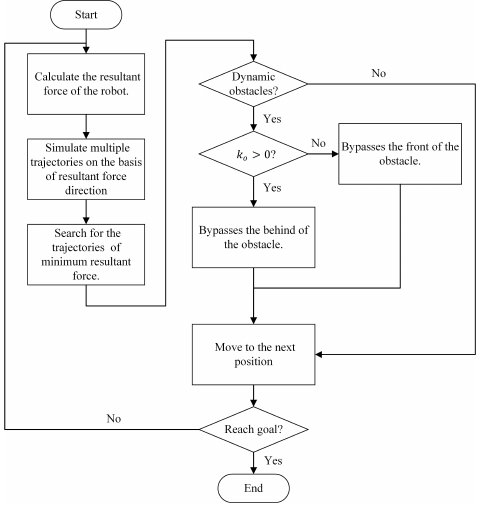
Figure 4. Danger Index Based Artificial Potential Field (DIAPF) based moving obstacle avoidance